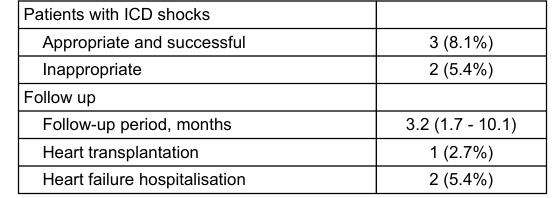
Table 3: Outcome data of patients undergoing S-ICD